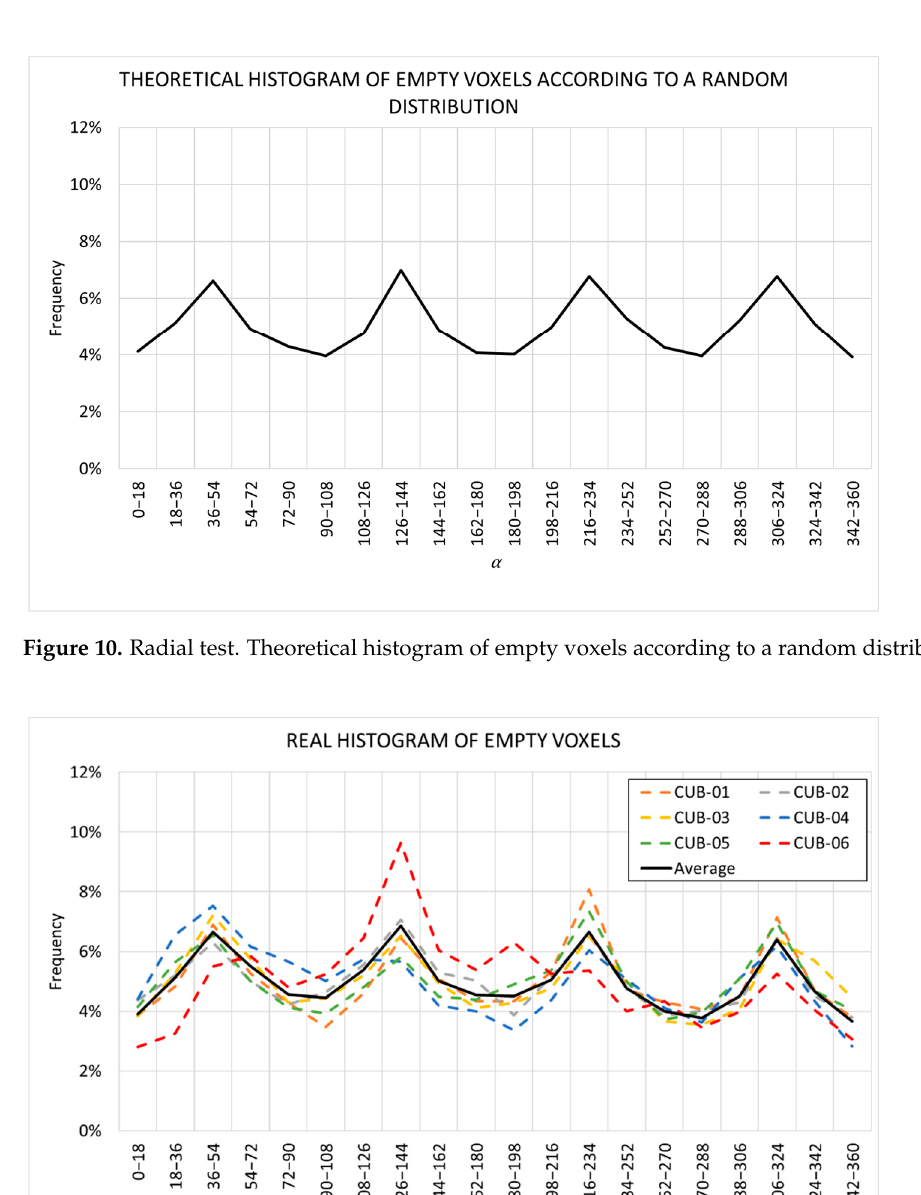
Figure 11. Radial test. Real histogram of empty voxels.